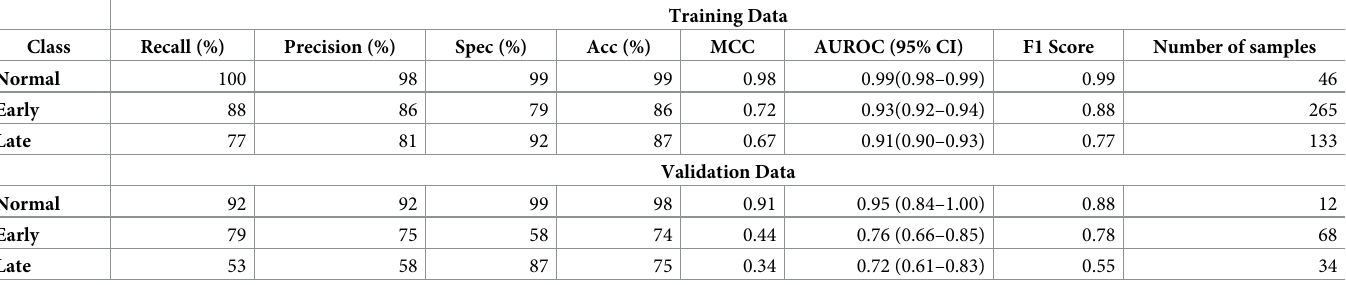
Table 5. The performance measures of the multiclass prediction model developed based on 107 features selected by SVC-L1 on training and validation dataset by implementing